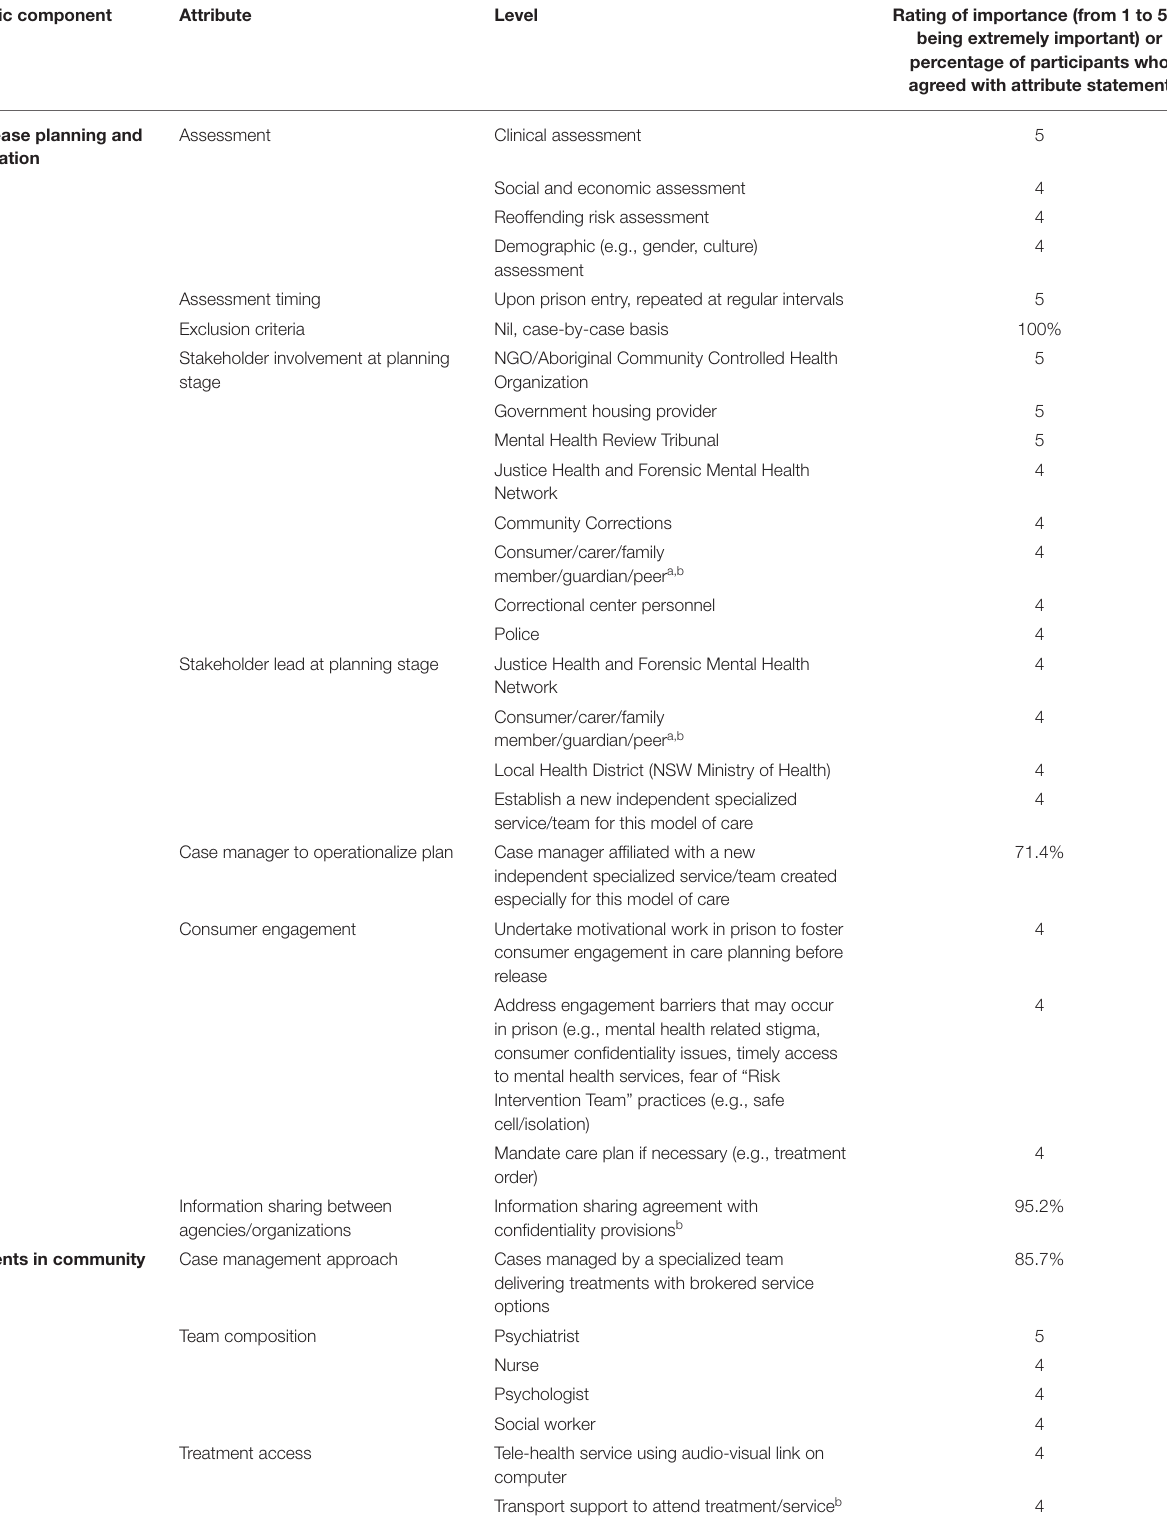
TABLE 2 | Optimal model of care attributes and levels scored by participants as important. Thematic component Attribute Level Rating of importance (from 1 to 5; 5